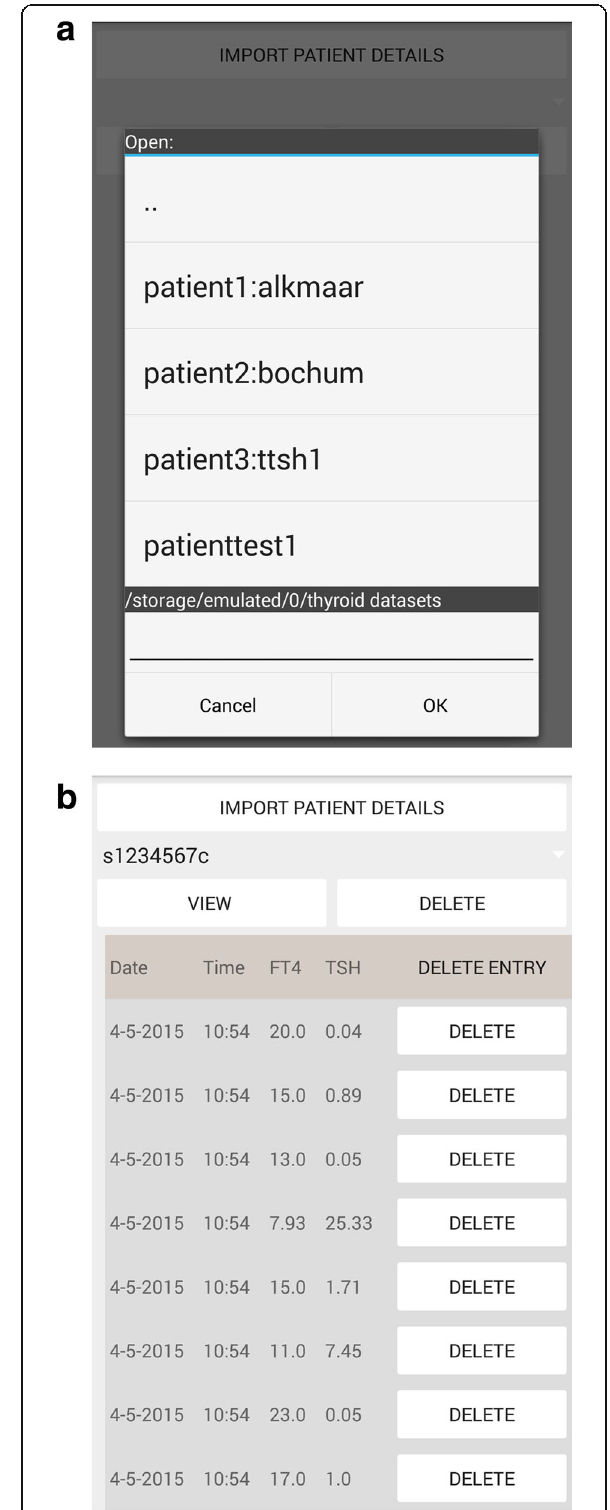
Fig. 2 Thyroid-SPOT Patient App ’ s graph analysis page. a The calculated curve. To be interpreted and shown to the attending clinician. b Exporting of patient data